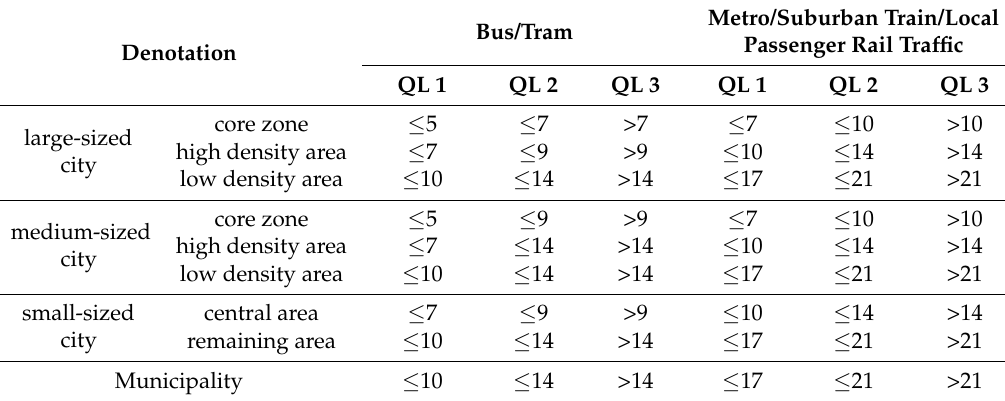
Table 3. Quality levels of accessibility (walking time) of public transport stops (unit minutes) (own depiction based on